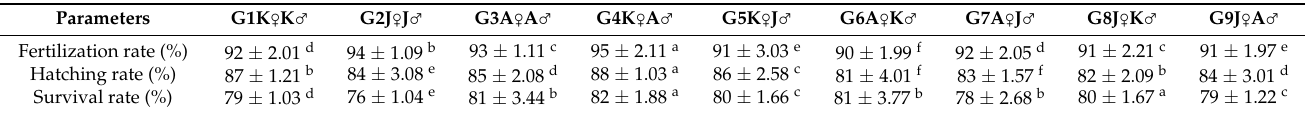
Table 3. Fertilization, hatching and survival rates of three parental and six reciprocal crosses of Ariza labeo ( L. ariza ) during seed production † . The single words picked to name the purebred and crossbred groups bear the full forms as G → Group, K → Kangsha River stock, J → Jamuna River stock and A → Atrai River